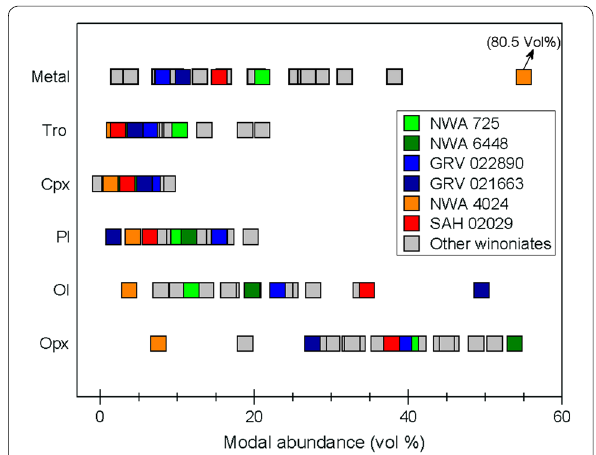
Fig. 4 Modal abundance (by area %) variation of the major phases in the winonaites (Table 1). They are orthopyroxene (Opx), olivine (Ol), plagioclase (Pl), clinopyroxene (Cpx), troilite (Tro), and metal (including the Fe-rich weathering products produced from metal and troilite). The color symbols represent the studied winonaite samples. The light gray symbols represent the reported data for